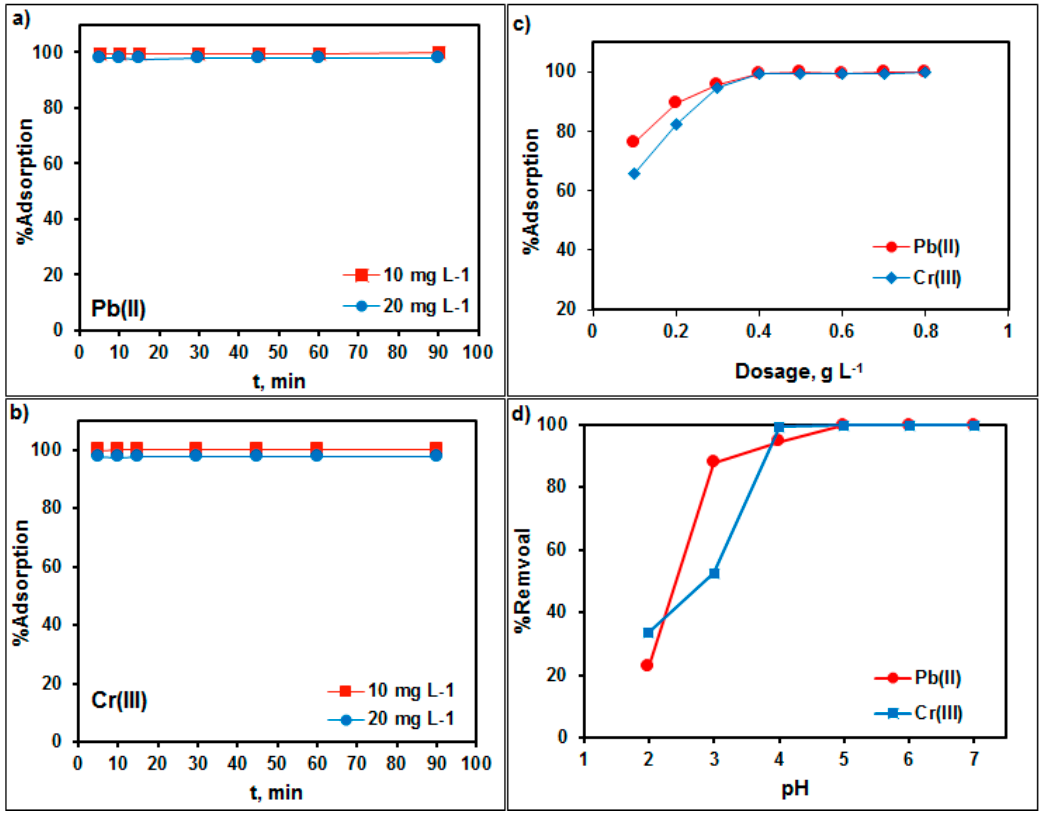
Figure 6. Factors such as equilibrium time ( a , b ), rGONF dosage ( c ), and aqueous solution pH ( d ) effect on the adsorption of Pb(II) and Cr(III) onto rGONF at 298 ± 2 K.